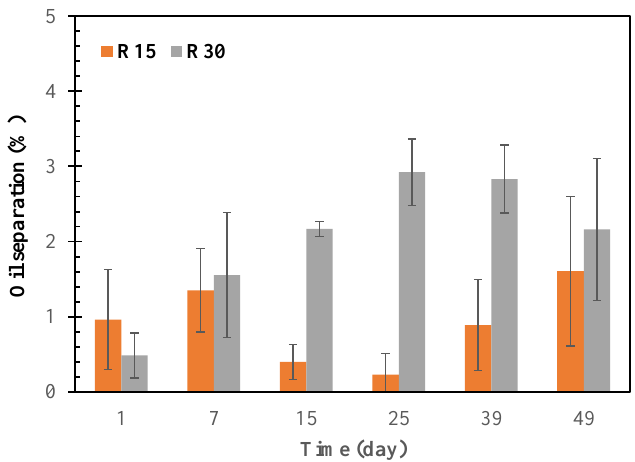
Figure 4. Changes in the rate of oil separation from the cottonseed butters during 49 days of storage at room temperature (25 ◦ C). B15 and B30, cottonseed butter made from glandless cottonseed kernels roasted at 150 ◦ C for 15 and 30 min, respectively. Data are presented as averages with standard deviation bars ( n = 3).